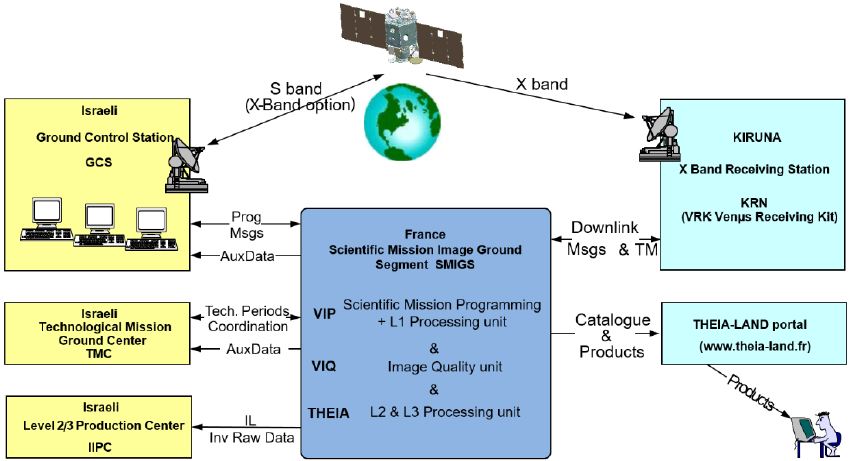
Figure 31. VEN μ S system